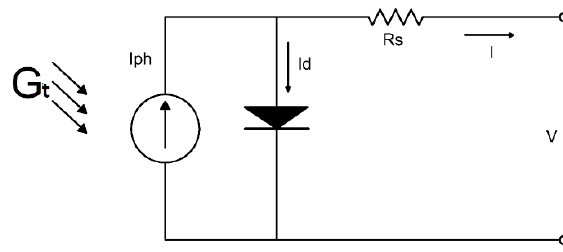
Figure 5. Single diode PV model.